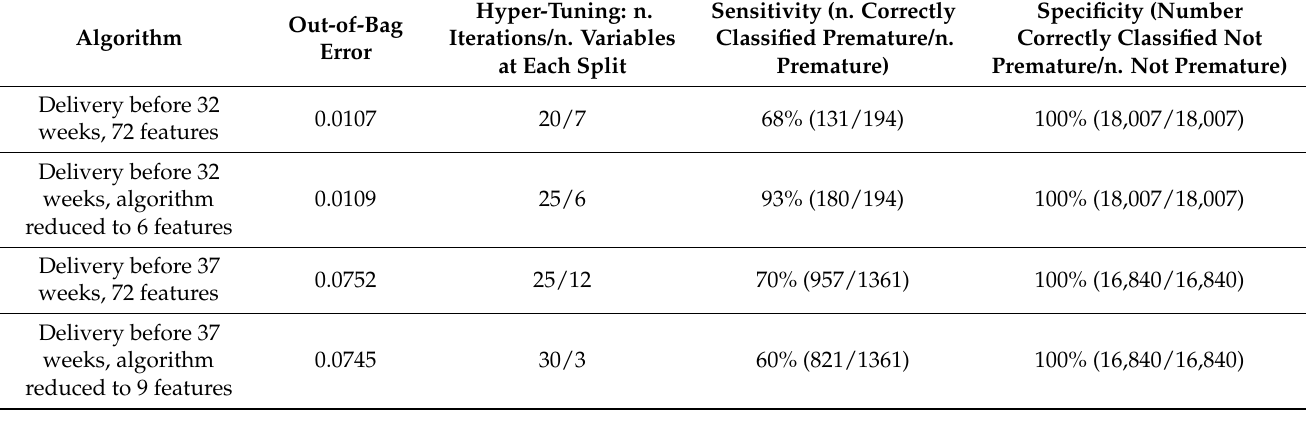
Table 3. Summary of the RF results for algorithms with 72 features, and after feature reduction. Lower out-of-bag error indicates less error.